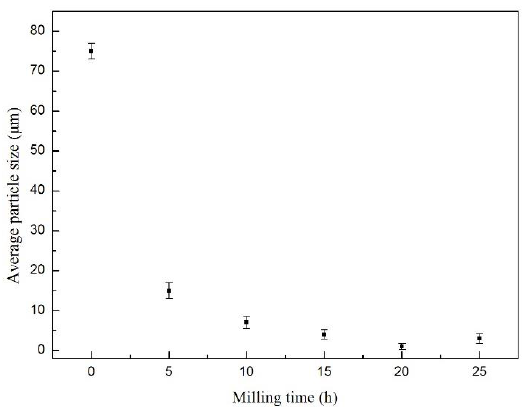
Figure 2. The average particle size of milled Cu-based alloy powders as a function of milling time.